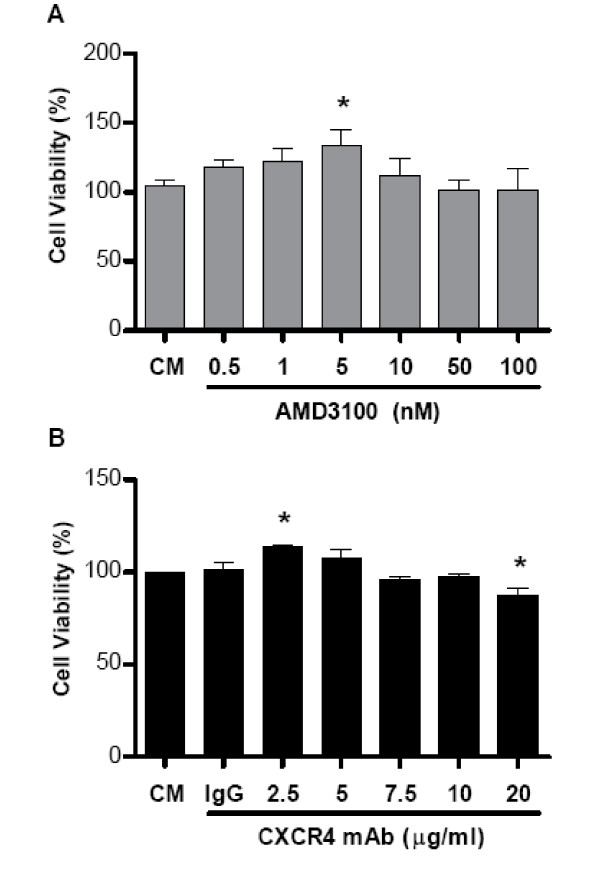
Cell viability of MCF7 breast cancer cells following treatment with either AMD3100 or the CXCR4 blocking mAb. Cells were treated with (A) CXCR4 antagonist AMD3100 (0.5 - 100 nM) and (B) the blocking mAb, MAB172 (2.5 - 20 μg/ml) for 24 hrs at 5% CO2 at 37°C. Control IgG2b mAb, MAB004 (10 μg/ml) was used as the control. Data are expressed as the mean ± SD of duplicate samples and are representative of three independent experiments. *p < 0.05 versus (A) culture medium (CM) or (B) control mAb (IgG) treated cells.